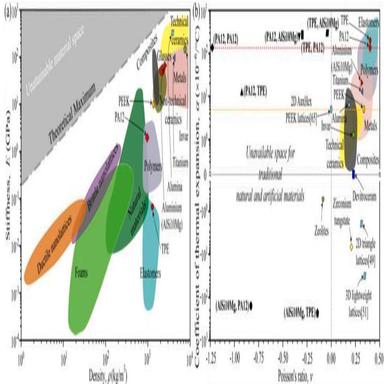
Material property charts plotting comparison with other natural and artificial materials and structures, (a) compressive effective stiffness against density, (b) CTE against Poisson's ratio.